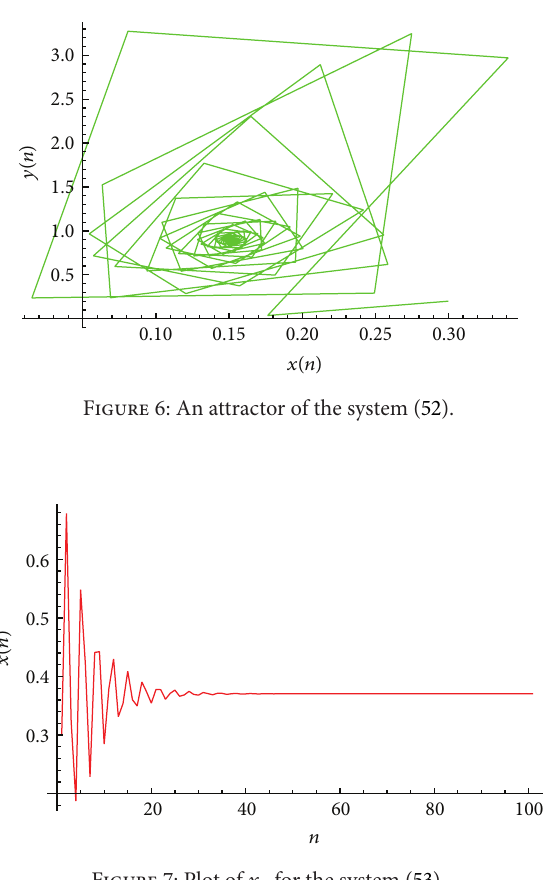
Figure 9: An attractor of the system